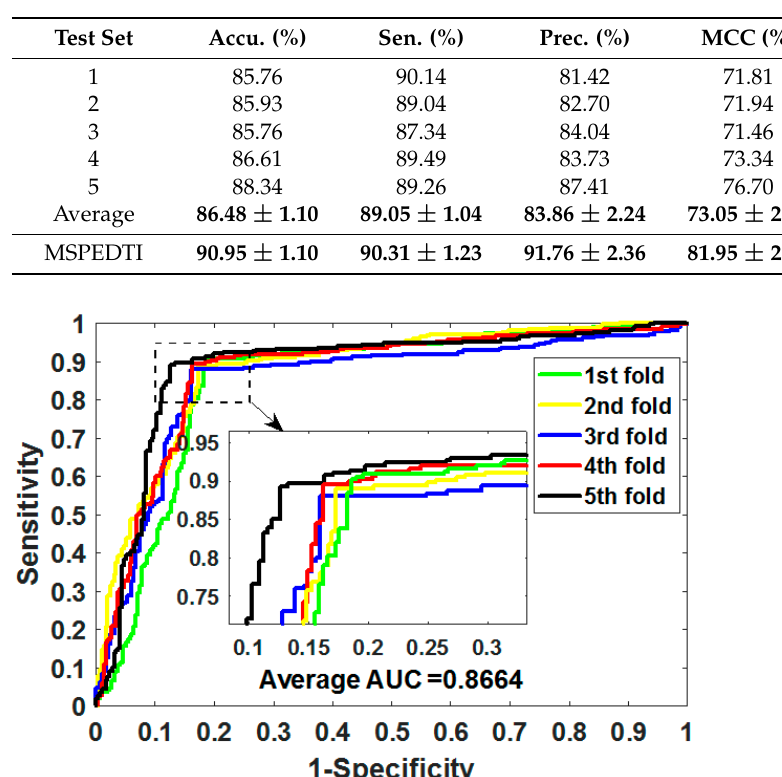
Table 7. Comparison outcomes of SVM model and MSPEDTI on ion channel.